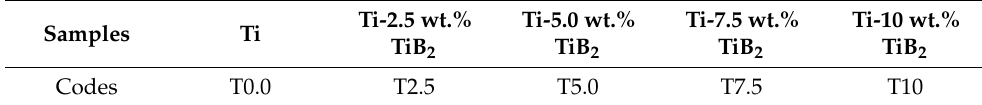
Table 1. Sintered sample codes.